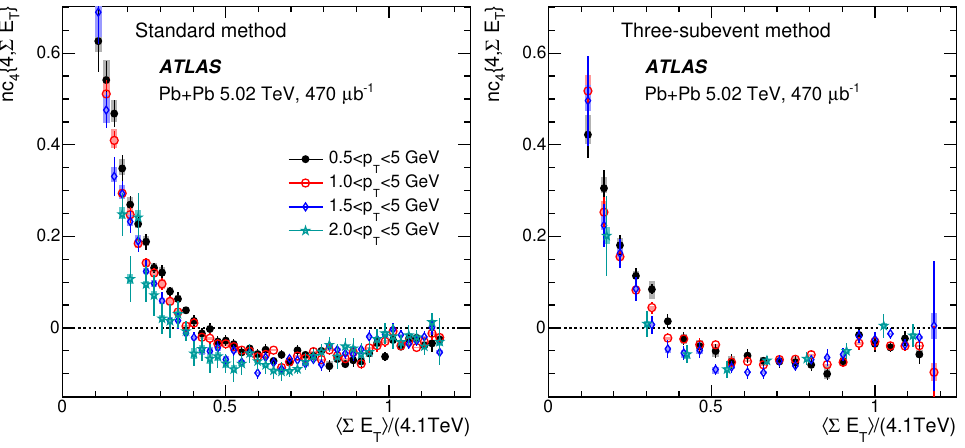
Figure 27 . The nc 4 f 4 g values calculated for charged particles in several p T ranges with the standard cumulant method (left) and three-subevent method (right). The error bars and shaded boxes represent the statistical and systematic uncertainties, respectively. Zero is indicated by a dotted